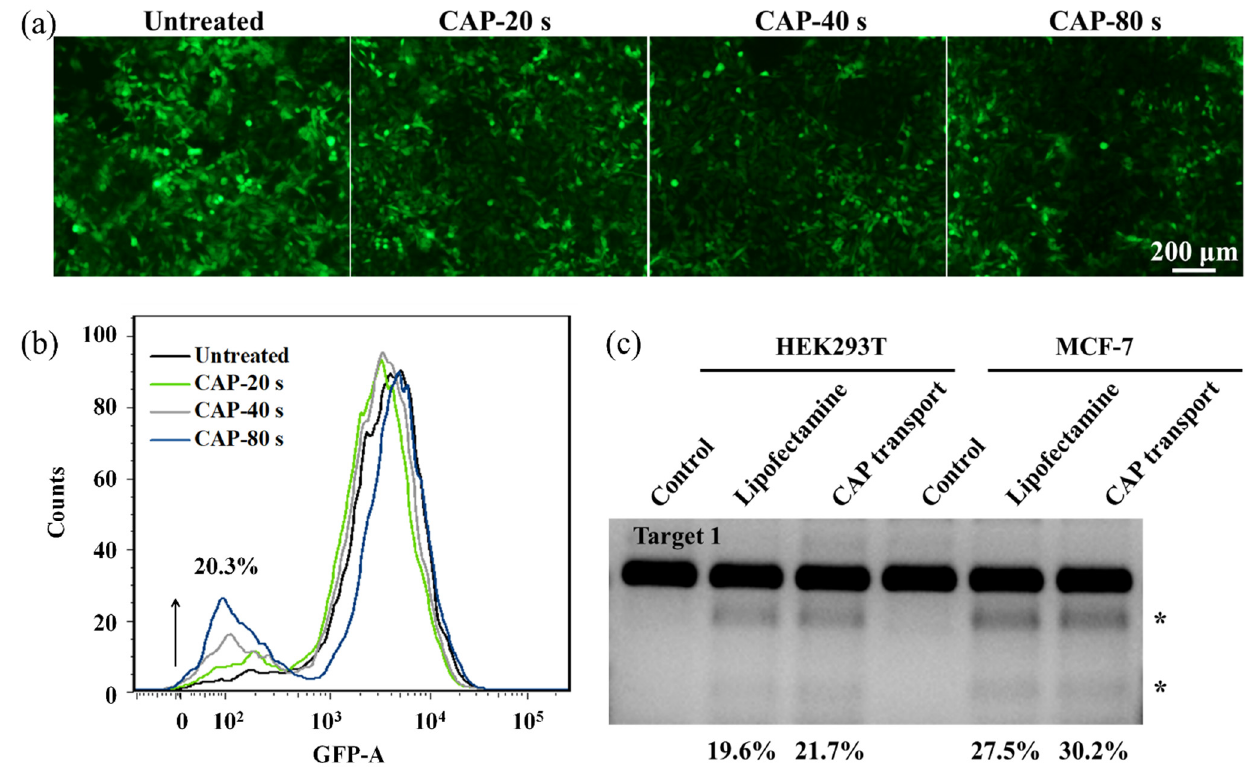
Figure 8. Genome editing of Cas9sg delivered by CAP treatment: ( a ) Fluorescence images of the A549/EGFP cells treated with Cas9sg for five days after CAP exposure for different time; ( b ) Flow cytometry of the A549/EGFP cells treated with Cas9sg for five days after CAP exposure for different time; ( c ) Indel analysis of HEK293T and MCF-7 cells treated with Cas9sg via Lipofatamine transfection and CAP treatment (C Cas9sg = 8 nmol L − 1 ). The asterisk (*) indicates the cleavage bonds of Cas9sg at Target 1 sites in chromosome 9.